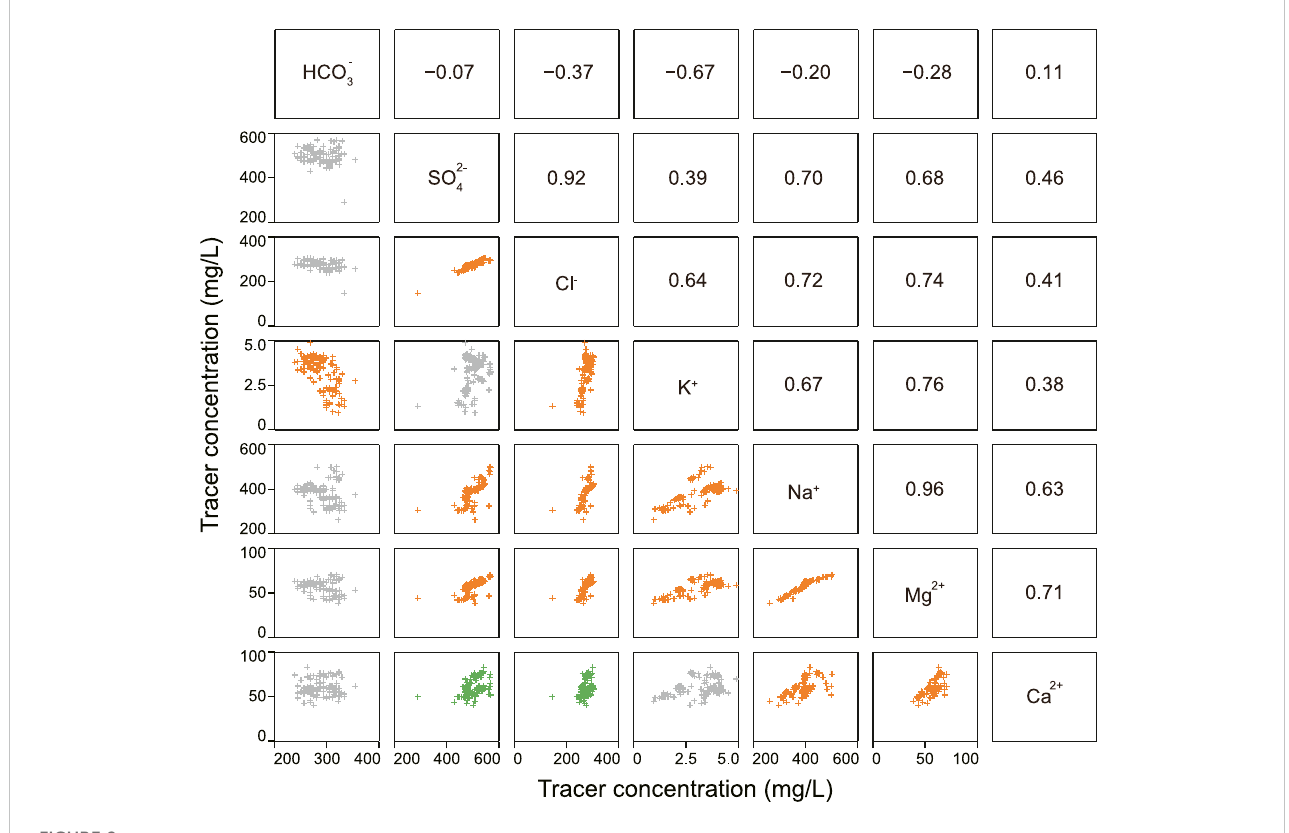
FIGURE 2 Bivariate plots of spring water chemistry at the X10 spring. The top half of the plots represents the Pearson ’ s correlation coef fi cient ( r ) for the linear relationship between each